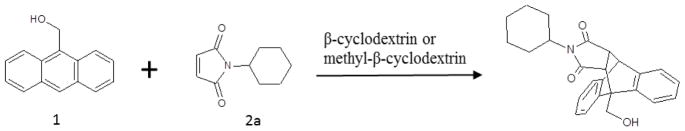
The Diels-Alder reaction of 9-anthracenemethanol (1) with N-cyclohexyl maleimide (2a), with β-cyclodextrin or methyl-β-cyclodextrin as a catalyst.